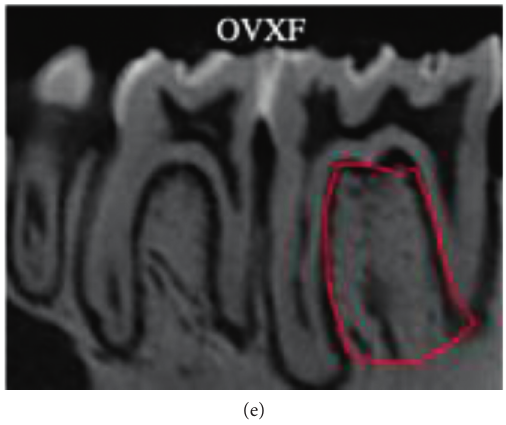
Figure 7: The sagittal section of the interradicular bone of the molar tooth (represented by the red